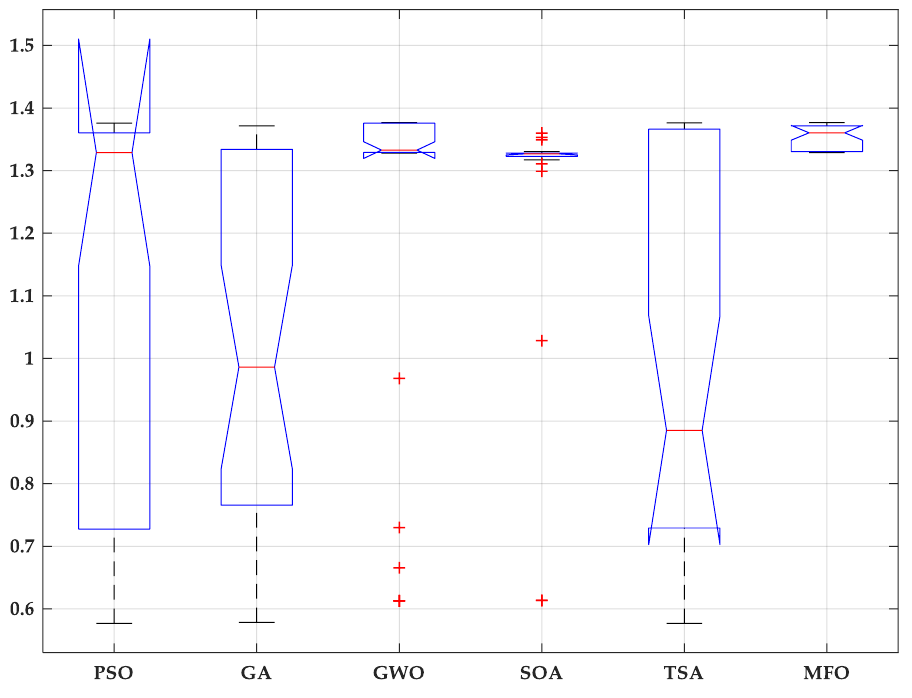
Figure 8. ANOVA test results.